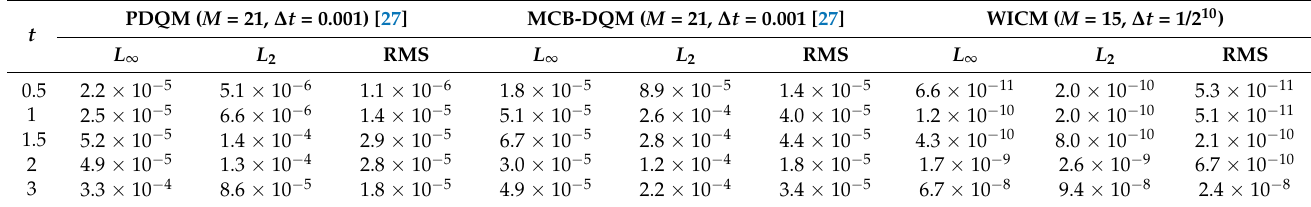
Table 4. Error norms of numerical solutions for Example 2.